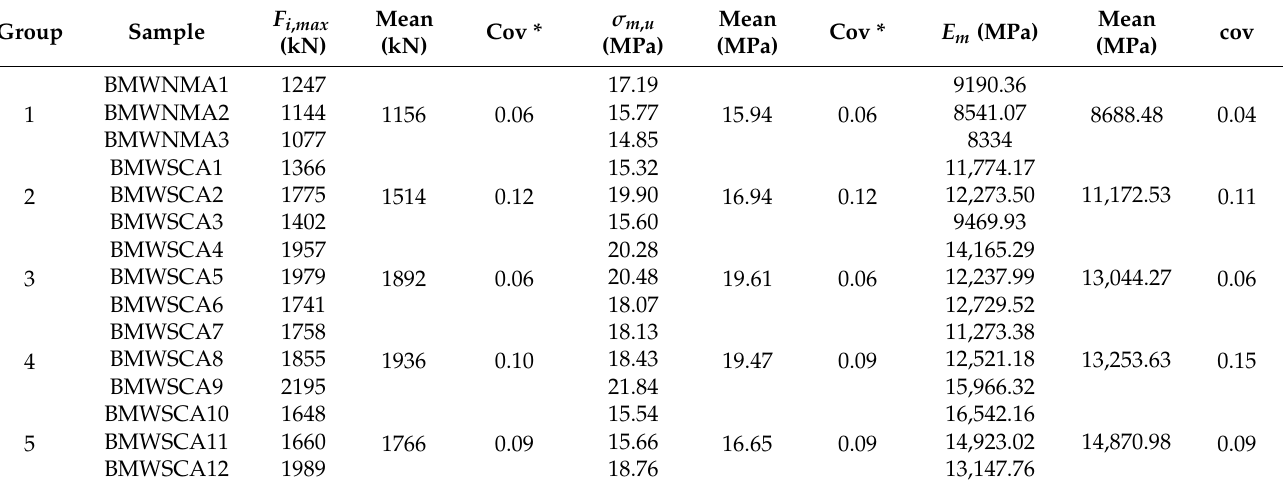
Table 7. Summary for masonry sample test